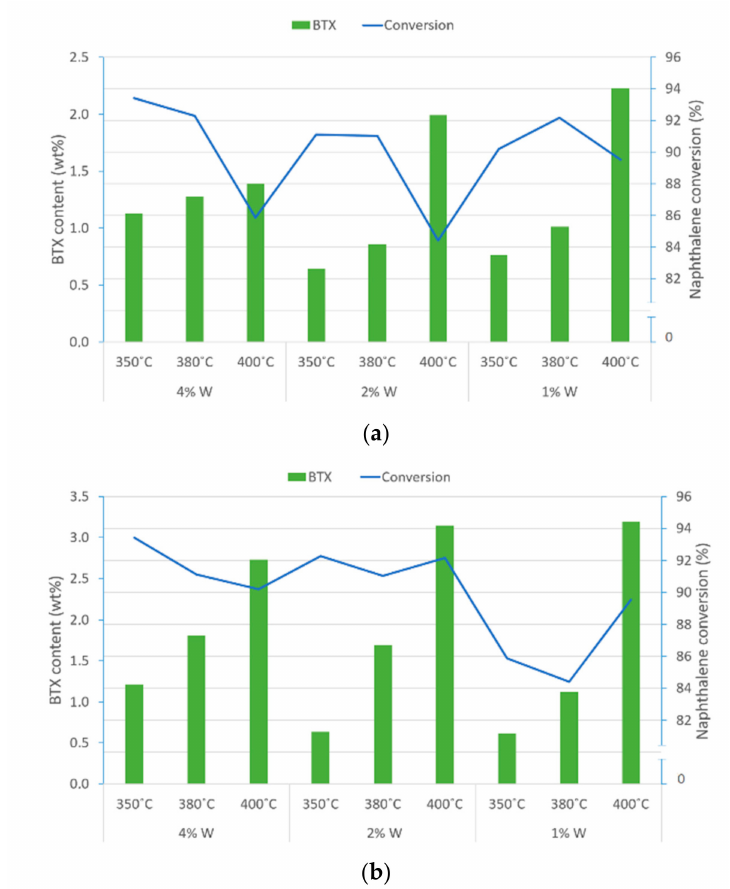
Figure 1. Naphthalene conversion versus tungsten molar ratio and reaction temperature, and benzene, toluene, and xylene (BTX) selectivity with ( a ) NiWS-HY(0.5%), ( b ) NiWS-HY(1%) catalysts at standard conditions P = 5 MPa, t = 5 h, and W:Ni ratio =